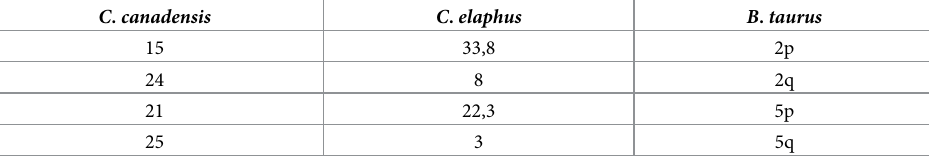
Table 3. Inter-chromosomal translocation comparisons among Cervus species and